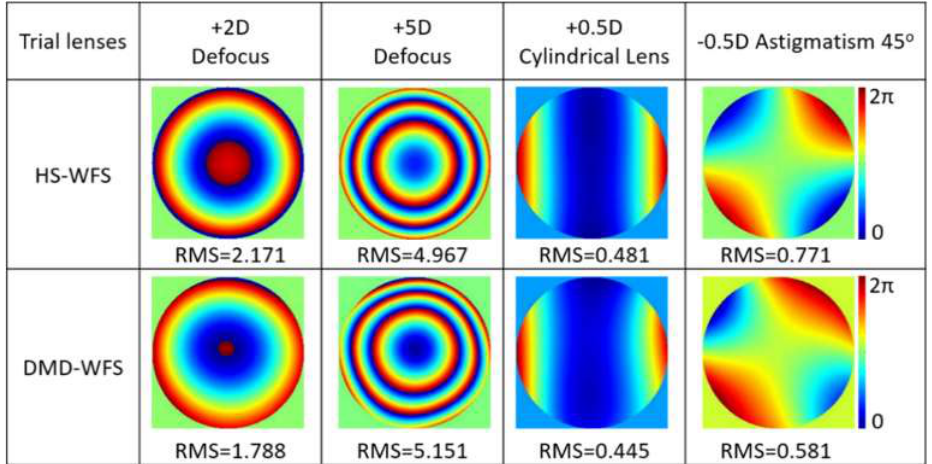
Figure 3. Wavefront reconstructions of an aberrated wave across a 4 mm pupil with ophthalmic trial lenses using the 5 × 5 sampling DMD-WFS method and a 2D-lateral position detector placed in the image plane. All RMS values are given in μm.